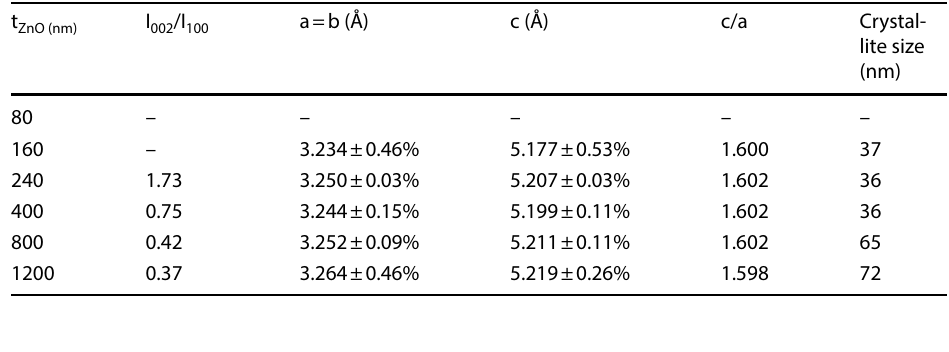
Table 1 Lattice parameters and crystallite size of ZnO thin films at different t ZnO